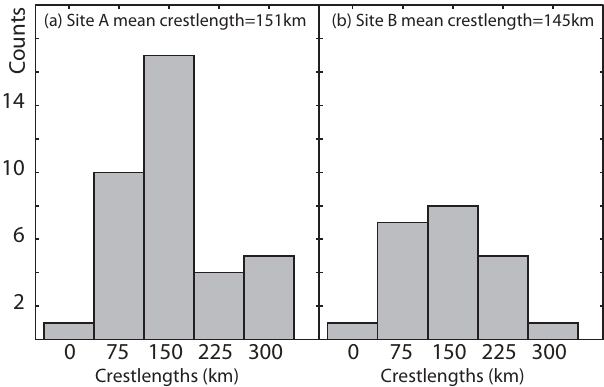
Figure 5. Crest length distribution for the leading ISWs in each